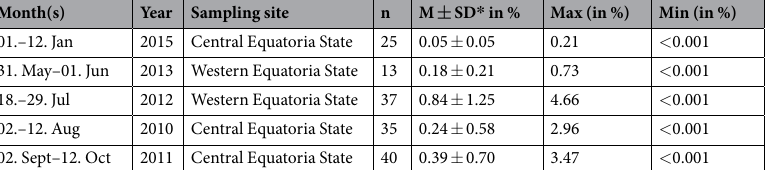
Table 4. Parasitemia of Hepatocystis infections across sampling seasons. Table 4 lists number of infected individuals, sampling month(s) and year, their corresponding mean parasitaemia (M) and Standard Deviation (SD) as well as maximum (Max) and minimum (Min) parasitaemia in